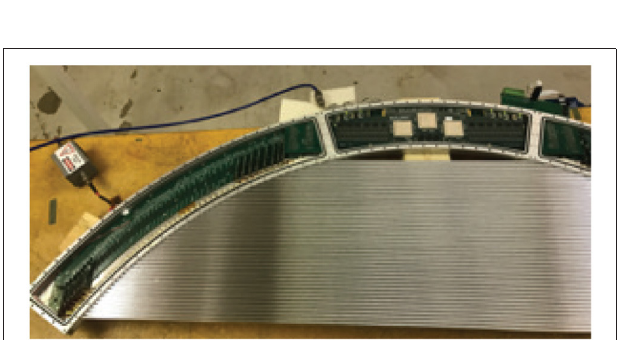
FIGURE 12 | One panel and the front end electronics for the Mu2e tracker. Figure from Bonventre [36].